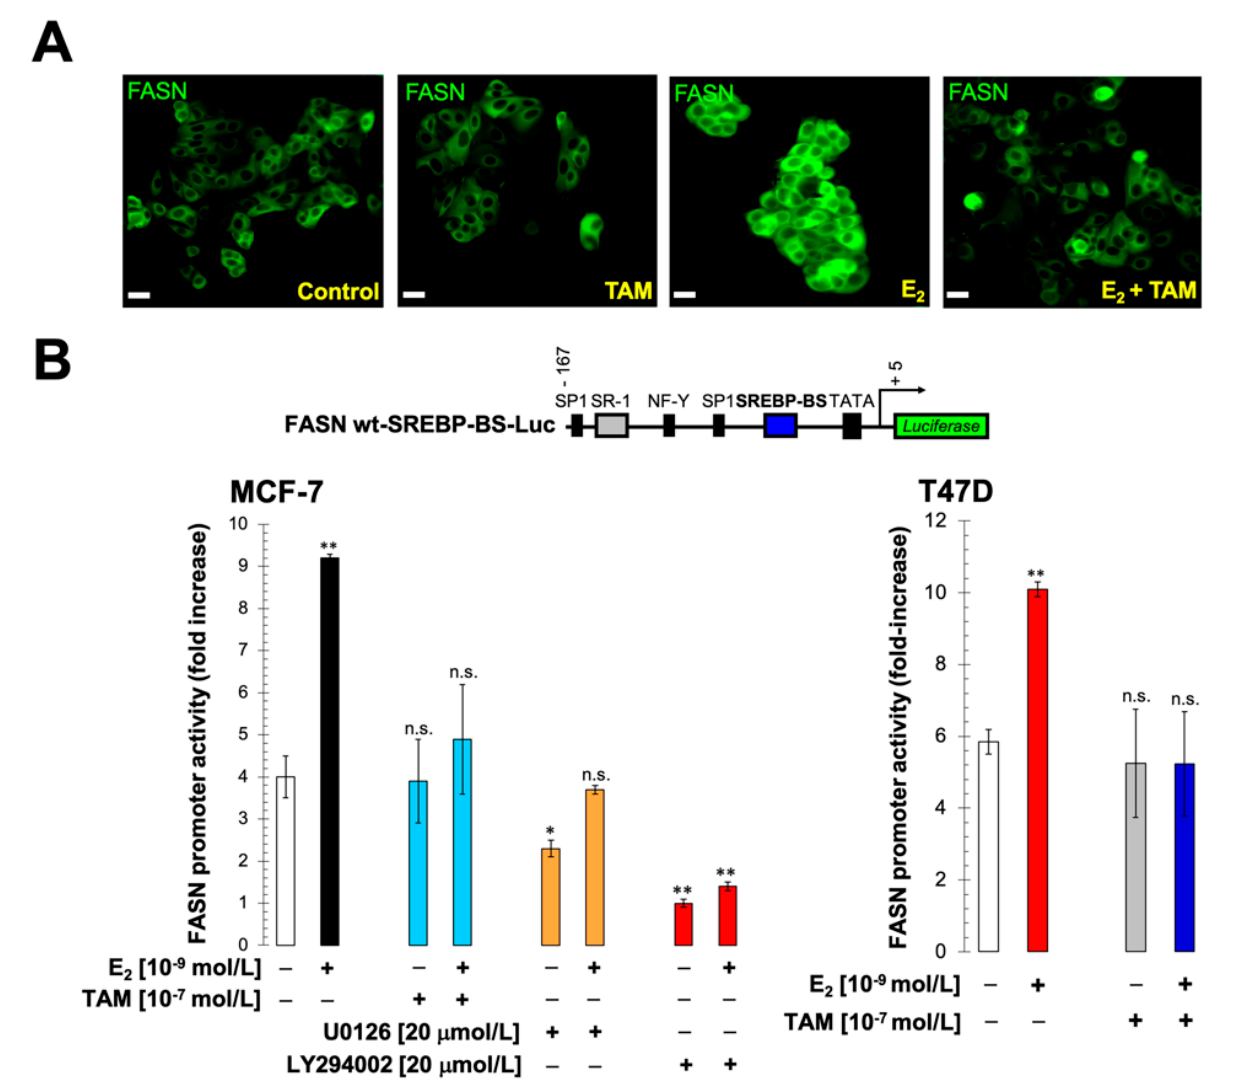
Figure 1. Estradiol supplementation up-regulates fatty acid (FA) synthase (FASN) protein expression in estrogen receptor-positive (ER+), luminal A-like MCF-7 breast cancer cells. ( A ) E 2 -depleted MCF-7 cells were seeded at 1 × 10 4 cells/well in a four-well chamber slide and, after 48 h incubation with 10 − 9 mol/L E 2 in the absence or presence of 10 − 7 mol/L tamoxifen (TAM), FASN cellular localization was evaluated after 2 h incubation with an anti-FASN mouse monoclonal antibody diluted 1:200 in 0.05% Triton X-100/PBS. After labeling, cells were extensively washed and localization of FASN was detected by indirect immunofluorescence using an FITC-conjugated anti-mouse IgG secondary antibody. A representative immunostaining analysis is shown. Similar results were obtained in 3 independent experiments. (E 2 : Estradiol; TAM: Tamoxifen; ER α : Estrogen Receptor alpha; FASN: Fatty acid synthase. Scale bar is 10 µ m). ( B ) MCF-7 (left) and T47D (right) cells were transiently transfected with a plasmid containing a luciferase reporter gene driven by a 178-bp FASN promoter fragment harboring a SREBP (sterol regulatory element binding protein)-binding site, flanked by auxiliary NF-Y and Sp-1 sites (top) or with a similar construct with the SREBP-binding site deleted (bottom). The next day, cells were treated with E 2 , tamoxifen, U0126, LY294002 or their combinations, as specified. After 24 h of exposure, cells were lysed, and luciferase activity was measured. luciferase activity was expressed as relative (fold) change in transcriptional activities of FASN promoter-luciferase-transfected cells in response to treatments after normalization to pRL-CMV activity, as described in “Material and methods”. Each experimental value represents the mean fold-increase (columns) ± S.D. (bars) from at least three independent experiments in which triplicate wells were measured. * p < 0.05 and ** p < 0.005, statistically significant differences from the untreated (control) group. n.s. not